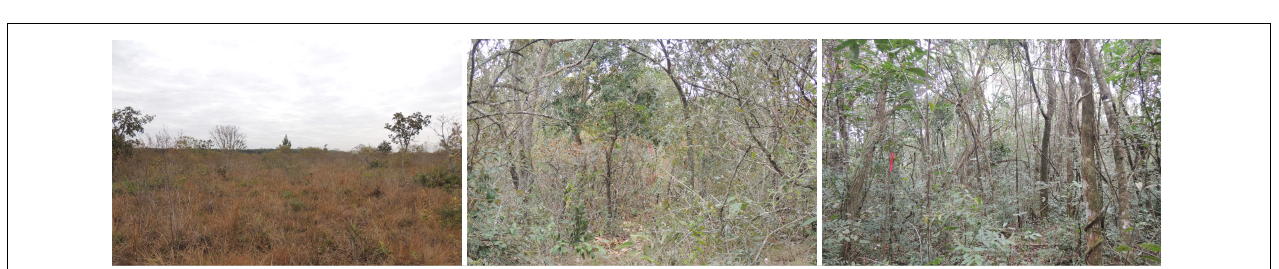
FIGURE 2 | The three main habitat types surveyed within the Cerrado. Grassland [left, “campo sujo (CS)” at the Santa Bárbara Ecological Station], Savanna [center, “cerrado sensu stricto (CE)” at the Santa Bárbara Ecological Station], and Forest [right, “cerradão (CD)” at the Santa Bárbara Ecological Station].